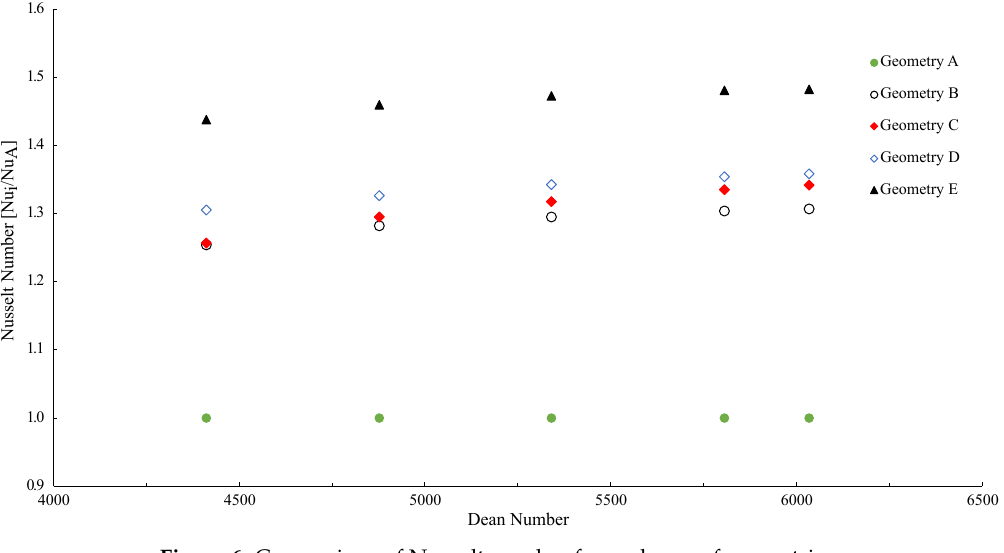
Figure 6. Comparison of Nusselt number for each one of geometries.